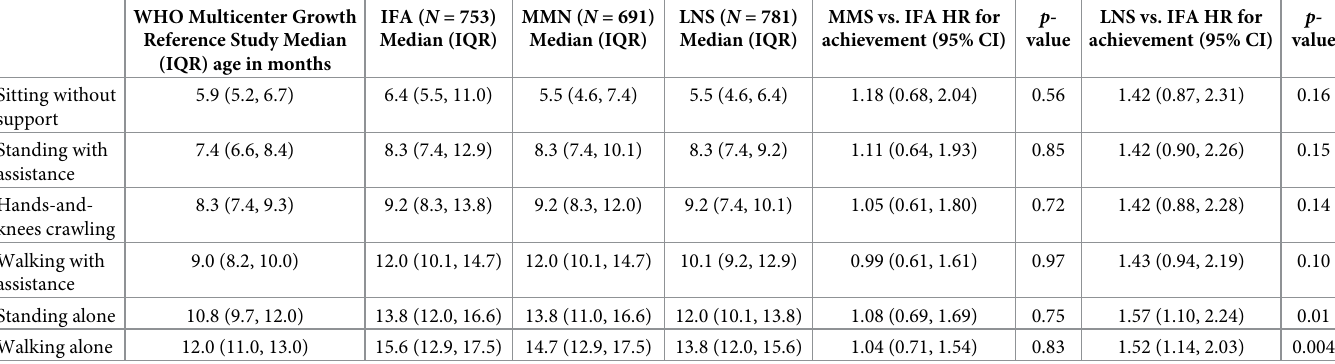
Table 3. Effect of MMS and LNS on time to achievement of the WHO gross motor milestones as compared to IFA. WHO Multicenter Growth Reference Study